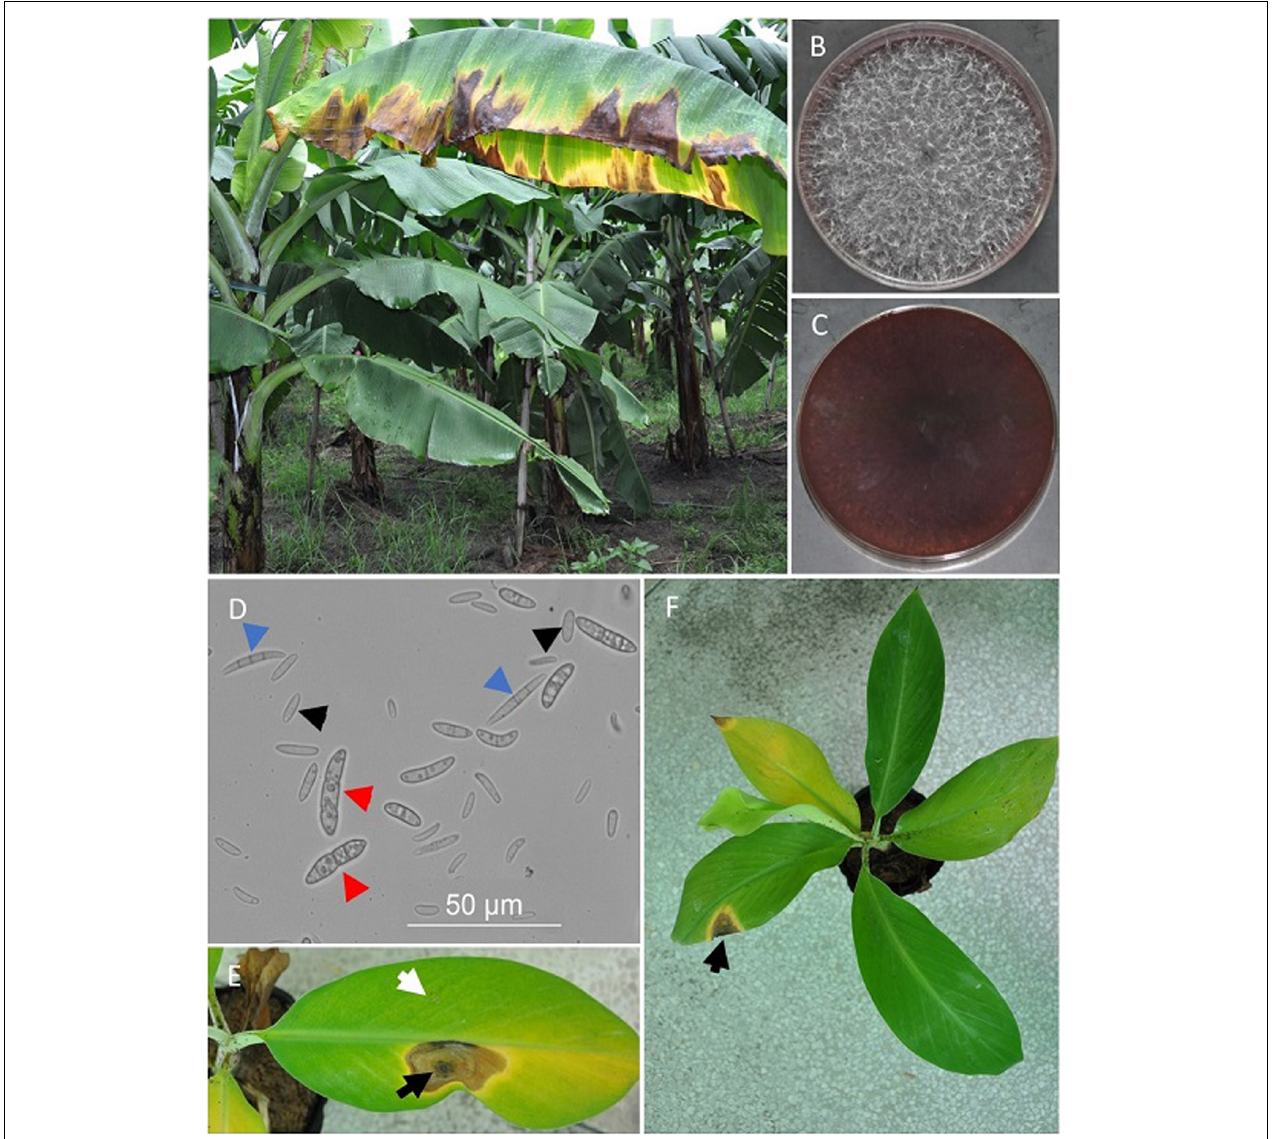
FIGURE 1 | Banana leaf blight disease and pathogen isolation. (A) Symptoms of the BLB disease in the field. (B,C) The appearances of the fungal colony at 7 days after single-spore inoculation on PDA plates from the front (B) and the back (C) . (D) Morphology of the fungal conidia and spores under the optical microscope. Blue, black, and red arrows denote large conidia, small conidia, and ascospores, respectively. (E) Symptoms on leaves inoculated with both the candidate pathogen and sterile water after the puncture. The white and black arrows pointed to the area punctured with needles and inoculated with water and FS66, respectively. (F) Symptoms on a banana seedling treated with leaf non-wound inoculation. Pictures (E,F) were taken at 30 days after inoculation.